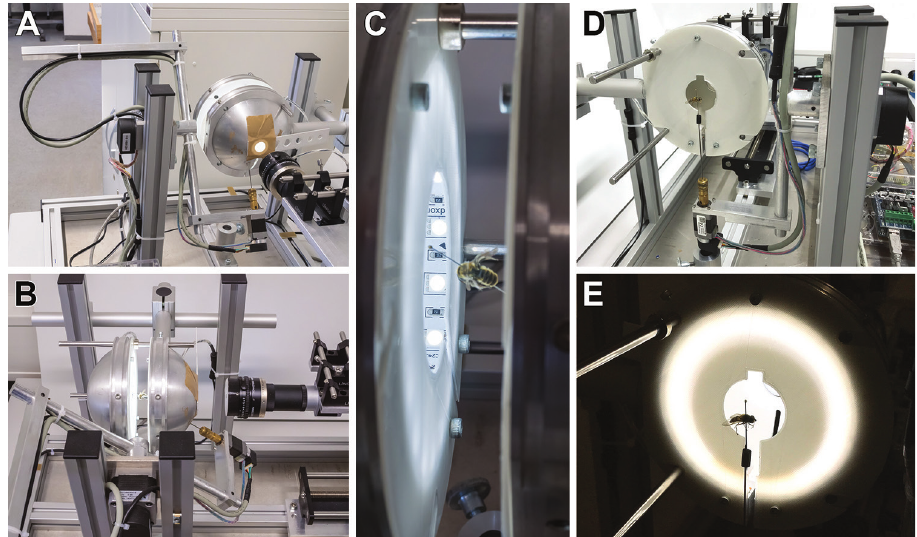
Figure 2. Illumination by two hemispherical white-coated domes ( A–C ). The back-light-dome can be removed for specimen mounting ( D, E ). No direct light from the LED-stripes hits the specimens ( C, E